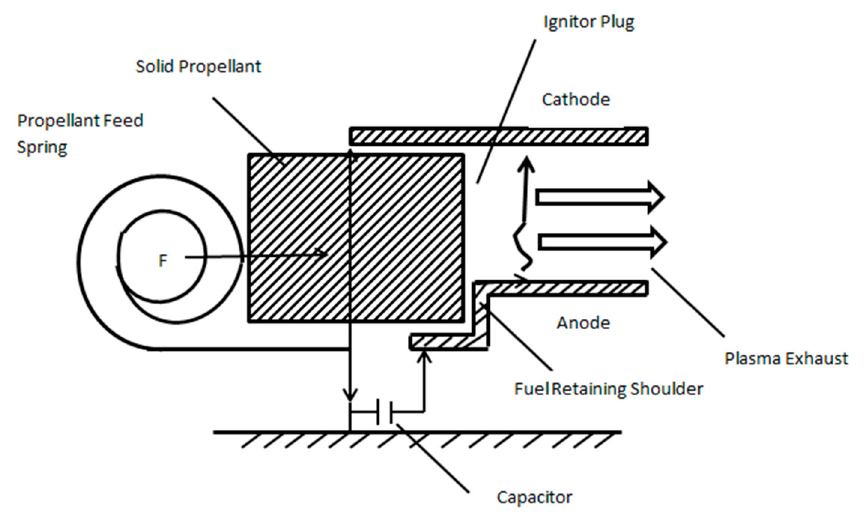
Figure 19. Pulsed Plasma Thruster Design [4].